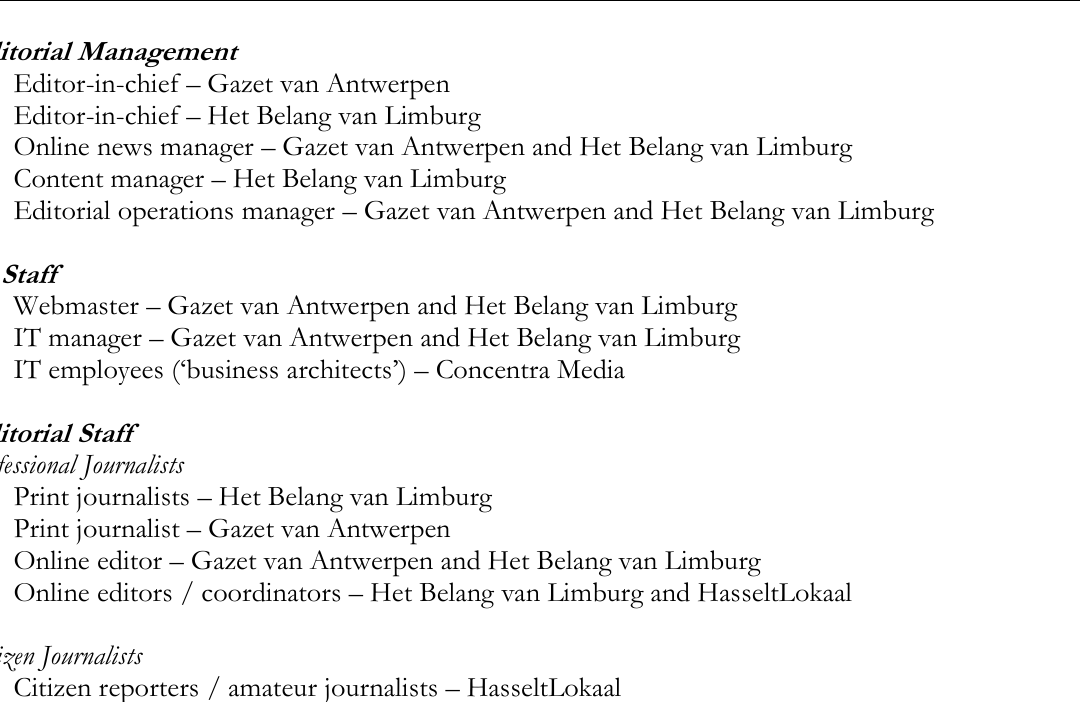
Table 1: Overview of the